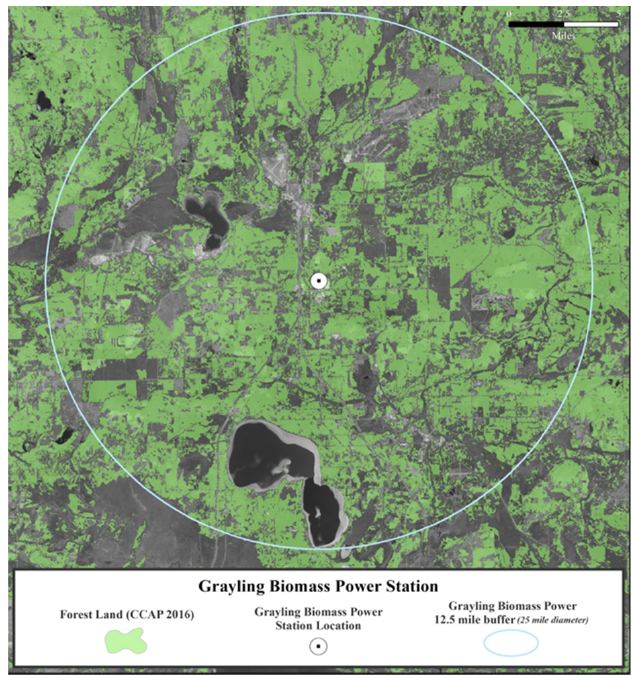
Figure 7. Forest land cover near the Grayling Generating Station, Crawford County, Michigan. Crawford County, where the Grayling Generating Station is located, has only